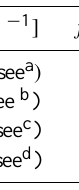
Table 2. Effective Henry’s law constants ( H ∗ ) at neutral pH and oxidative reactivity parameters ( f 0 ) for calculating the dry deposi- tion velocities of inorganic bromine species except on the snow/ice covered